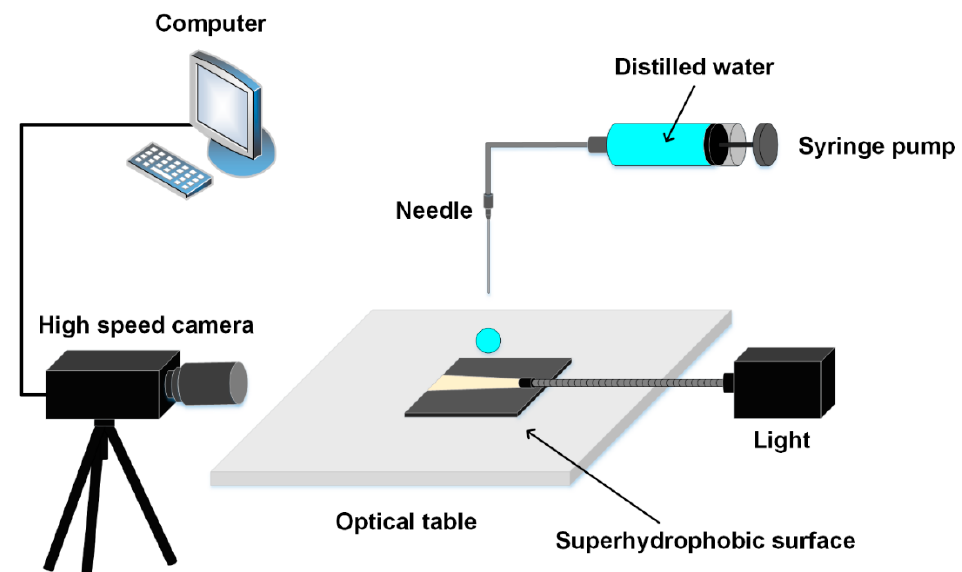
Figure 1. Schematic for the droplet impacting experiment.